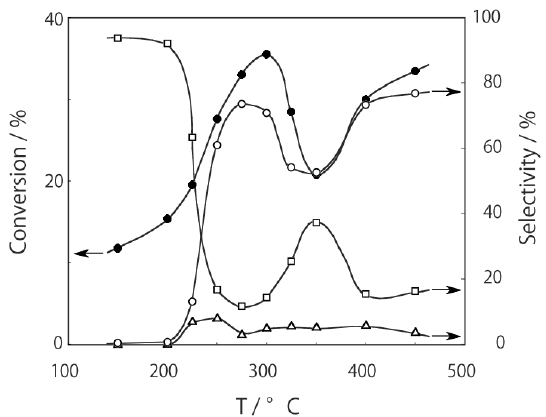
Figure 21. Effect of temperature on quinoline synthesis catalyzed by [(Nb Cl )Cl (H O) ]·4H O. Following activation of the supported cluster (30 6 12 2 2 4 2